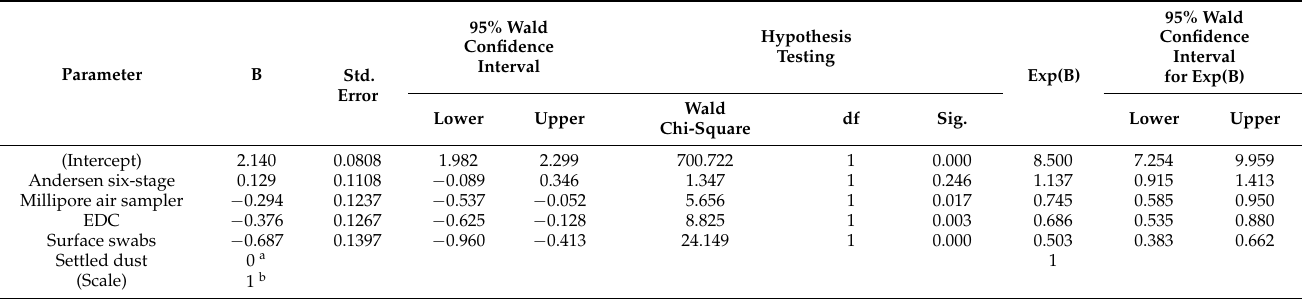
Table 5. Model 3: Identification of the Best Sampling